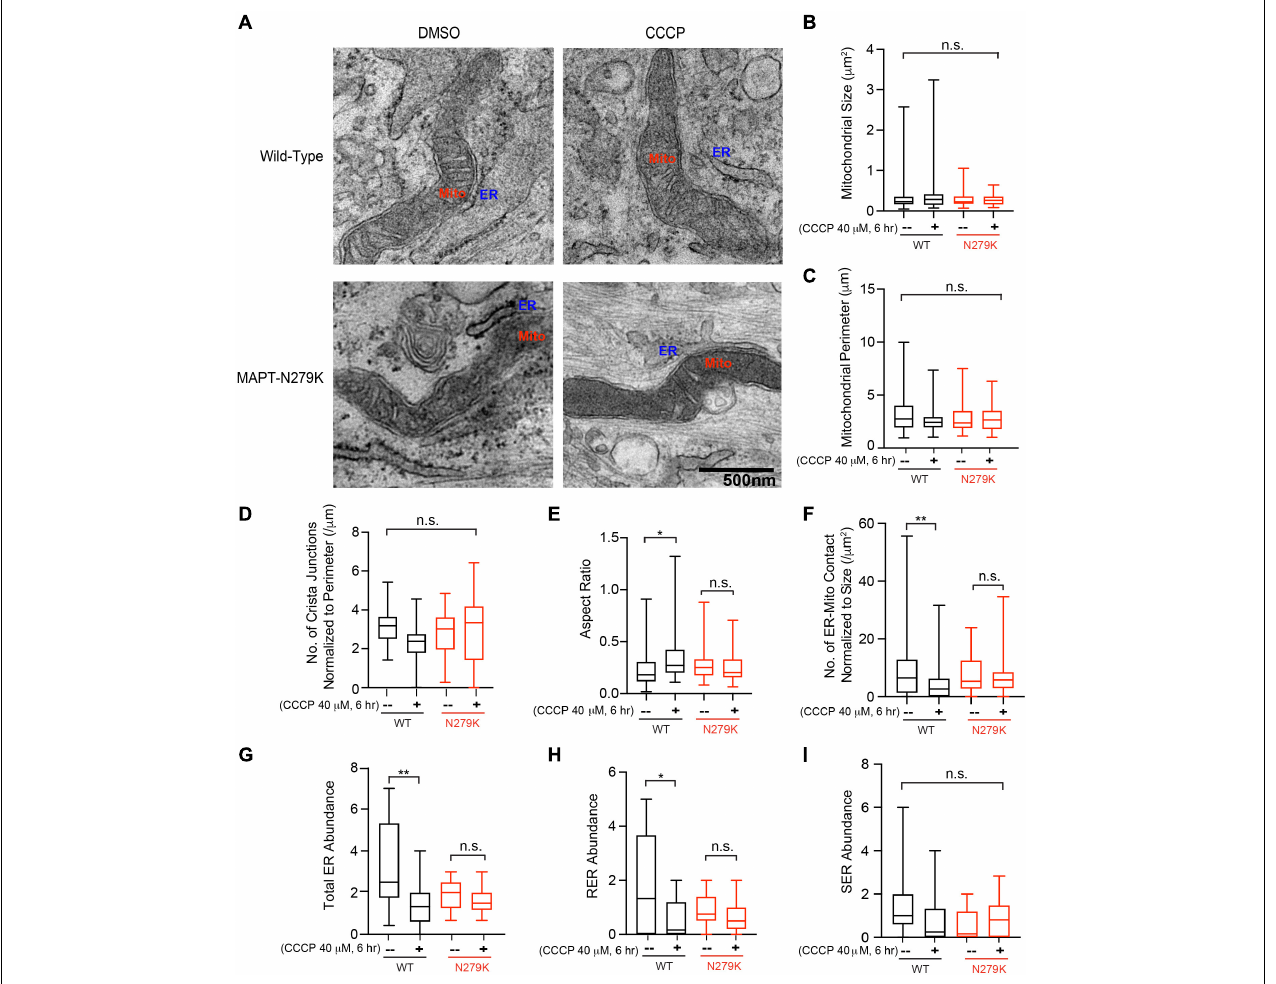
FIGURE 2 | Ultrastructural changes of mitochondria in fibroblasts. (A) Representative TEM images of Healthy-6 (WT) and MAPT-1 (MAPT-N279K) with and without CCCP treatment. Scale bar: 500 nm. (B–I) Quantifications from images as in (A) . (B) Quantification of mitochondrial size (minor × major diameter). (C) Quantification of mitochondrial perimeter. (D) Quantification of cristae junction number normalized to mitochondrial perimeter. (E) Quantification of aspect ratio (minor/major diameter). (F) Quantification of ER-mitochondrial contact number normalized to mitochondrial size (contact is defined where the distance between ER and mitochondrial membranes is less than 10 nm). (G) Quantification of total ER abundance (the total number of ER-mitochondrial contact divided by the total number of mitochondria per image). (H) Quantification of rough ER (RER) abundance. Similar to (G) but only RER is counted. (I) Quantification of smooth ER (SER) abundance. Similar to (G) but only SER is counted. N = 57 (WT, DMSO), 51 (WT, CCCP), 53 (MAPT-N279K, DMSO), and 64 (MAPT-N279K, CCCP) mitochondria from 15 different images from 3 independent cultures. Two-Way ANOVA Post Hoc Tukey Test. * P < 0.05, ** P < 0.01. n.s.: not significant.